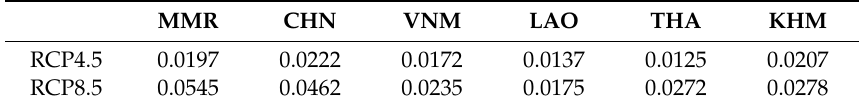
Figure 10. Variation of the number of days with extreme temperature in the Lancang-Mekong River subregion under the RCP4.5 ( a ) and the RCP8.5 ( b ). Table 1. Trends in the indices for temperature extremes.